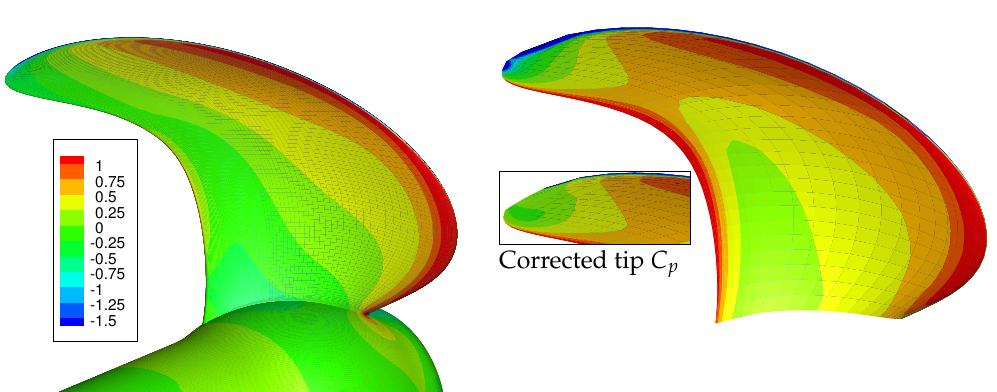
Figure 10. Pressure coefficient, C p , on the pressure side for J = 0.64, RANS ( left ) BEM ( right ). The insert figure shows the BEM pressure distribution after the tip pressure correction.